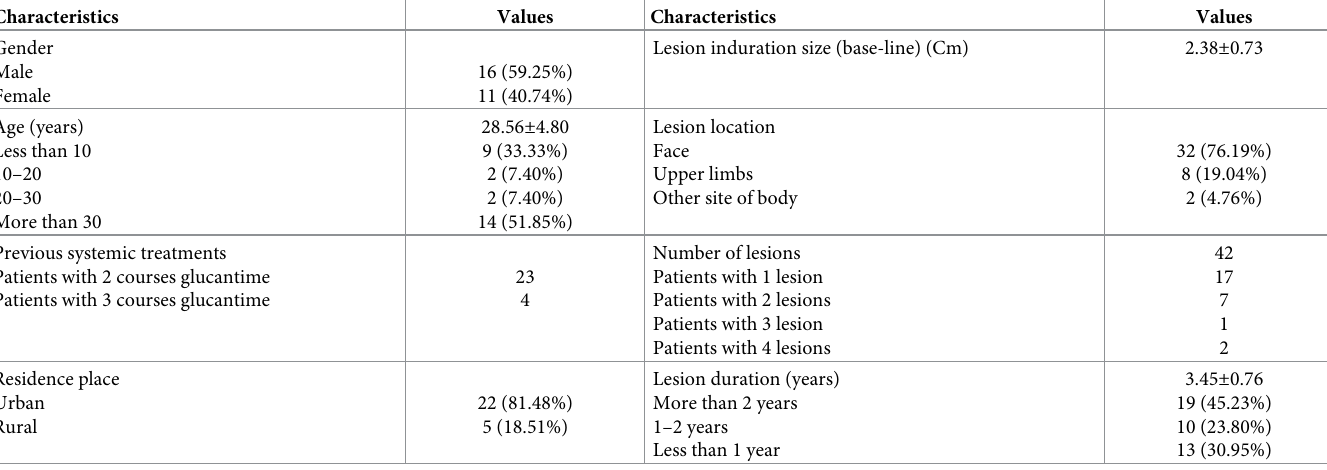
Table 1. Demographic data and clinical characteristics of 27 patients with acute anthroponotic cutaneous leishmaniasis registered in the study. Characteristics Values Characteristics Values